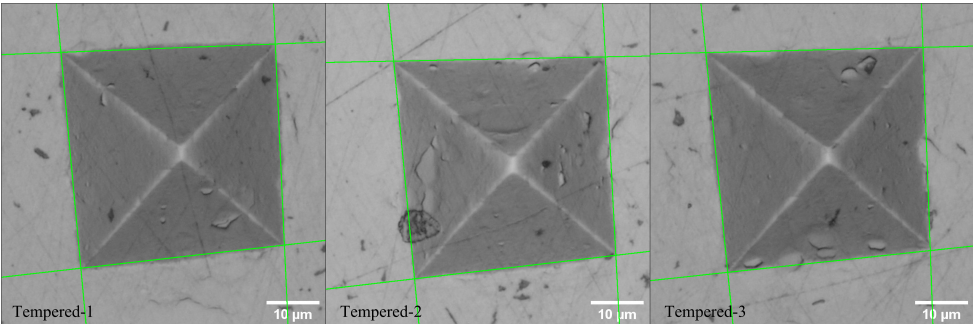
Figure A4. Corner detection on Quenched samples at 5N applied force.